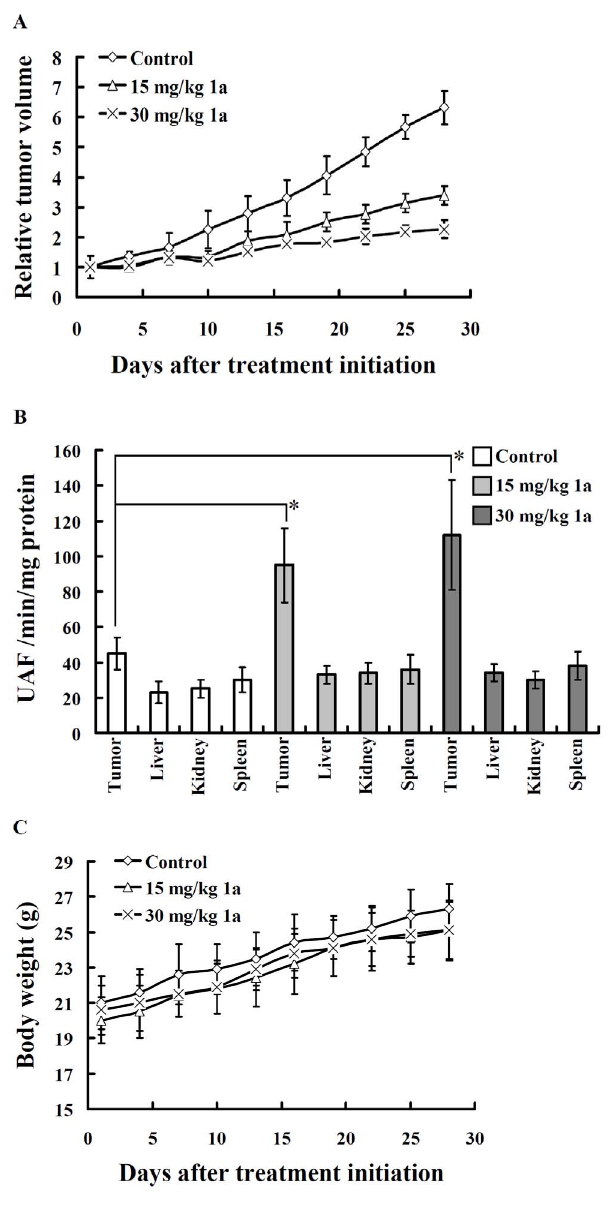
Figure 6. Inhibition of human oral cancer xenografts growth in vivo by compound 1a . ( A ) OEC-M1 tumor-bearing mice were administered s.c. with vehicle control ( e ), 15 mg/kg ( g ), or 30 mg/kg ( 6 ) compound 1a on days 0–4 for 5 days. The figure showed the relative tumor volume of control and compound 1a -treated groups. ( B ) Caspase 3 activity of tissues from OEC-M1 tumor-bearing mice (on day 28 after inoculation). ( C ) The changes of body weight of the tumor- bearing mice. Body weight was measured for each animal every three days starting from the day of the initial compound 1a treatment. All results are given as means 6 SD; n=6 for each group.*indicates a significant difference at the level of p , 0.05.